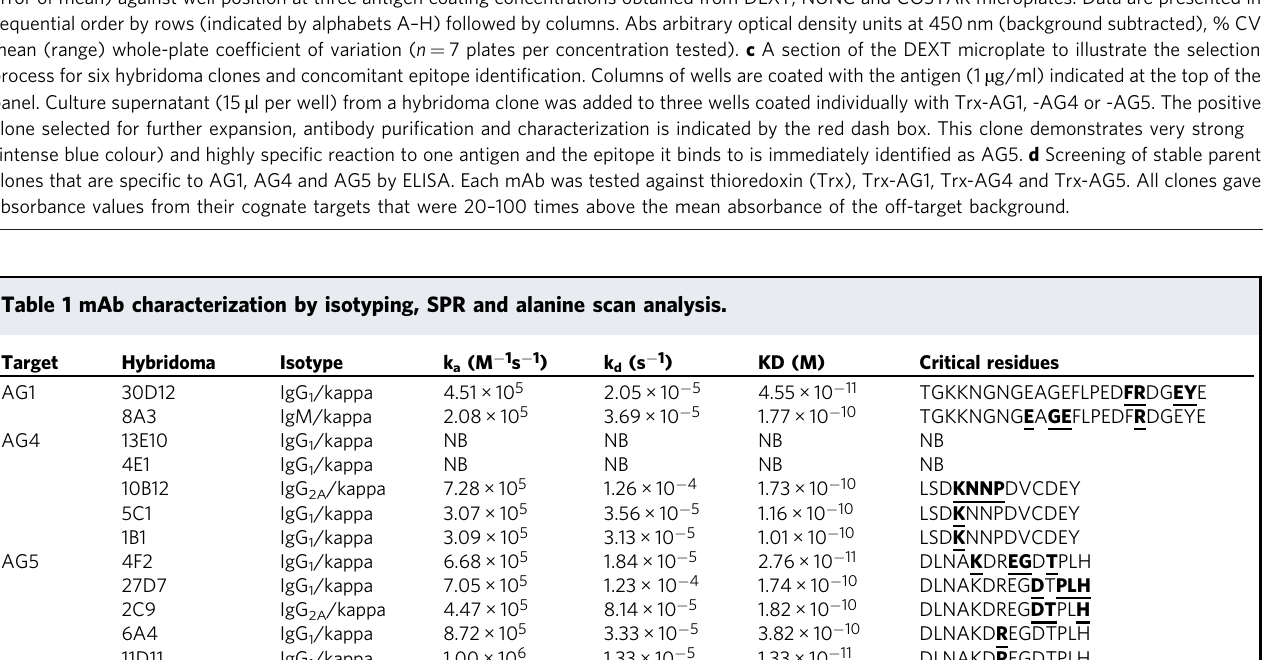
Fig. 3 Hybridoma screening using DEXT microplates. a Assemblage of DEXT microplates showing (i) fl at APET sheets with scribed wells, (ii) re-useable custom-made base, and (iii) re-useable lid with af fi xed micro fi ber cloth (red arrow). b Scatter plot of mean absorbance (vertical bars showing standard error of mean) against well position at three antigen coating concentrations obtained from DEXT, NUNC and COSTAR microplates. Data are presented in sequential order by rows (indicated by alphabets A – H) followed by columns. Abs arbitrary optical density units at 450 nm (background subtracted), % CV mean (range) whole-plate coef fi cient of variation ( n = 7 plates per concentration tested). c A section of the DEXT microplate to illustrate the selection process for six hybridoma clones and concomitant epitope identi fi cation. Columns of wells are coated with the antigen (1 µ g/ml) indicated at the top of the panel. Culture supernatant (15 µ l per well) from a hybridoma clone was added to three wells coated individually with Trx-AG1, -AG4 or -AG5. The positive clone selected for further expansion, antibody puri fi cation and characterization is indicated by the red dash box. This clone demonstrates very strong (intense blue colour) and highly speci fi c reaction to one antigen and the epitope it binds to is immediately identi fi ed as AG5. d Screening of stable parent clones that are speci fi c to AG1, AG4 and AG5 by ELISA. Each mAb was tested against thioredoxin (Trx), Trx-AG1, Trx-AG4 and Trx-AG5. All clones gave absorbance values from their cognate targets that were 20 – 100 times above the mean absorbance of the off-target background.